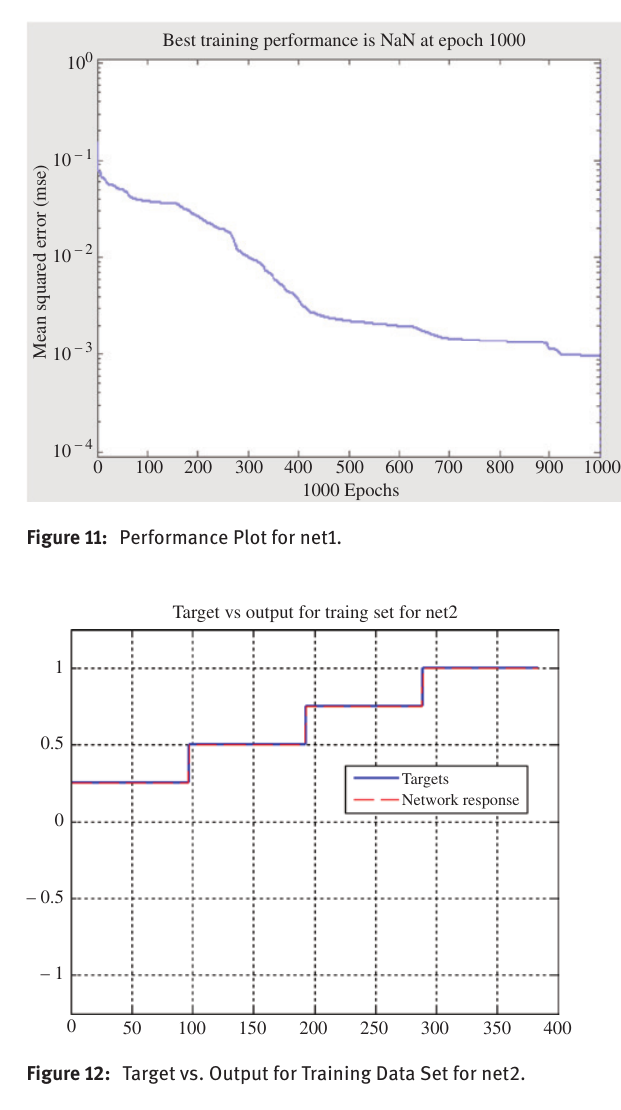
Best training performance is NaN at epoch 1000